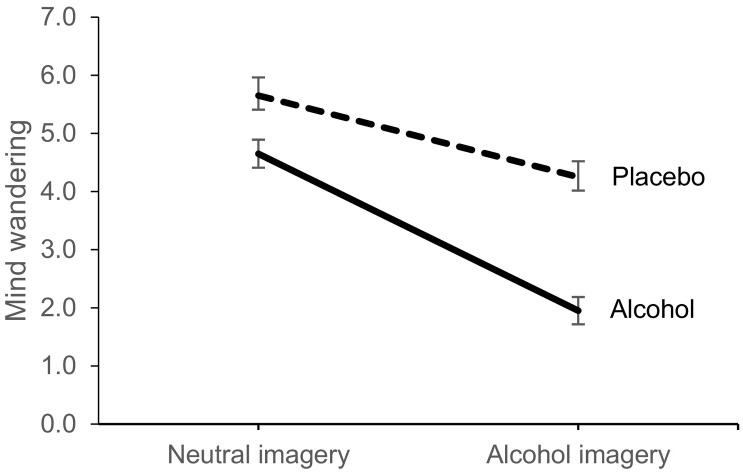
Mean (± SEM) scores for mind wandering retrospectively rated immediately after neutral and alcohol related mental imagery after placebo (dashed line) and alcohol (solid black line).